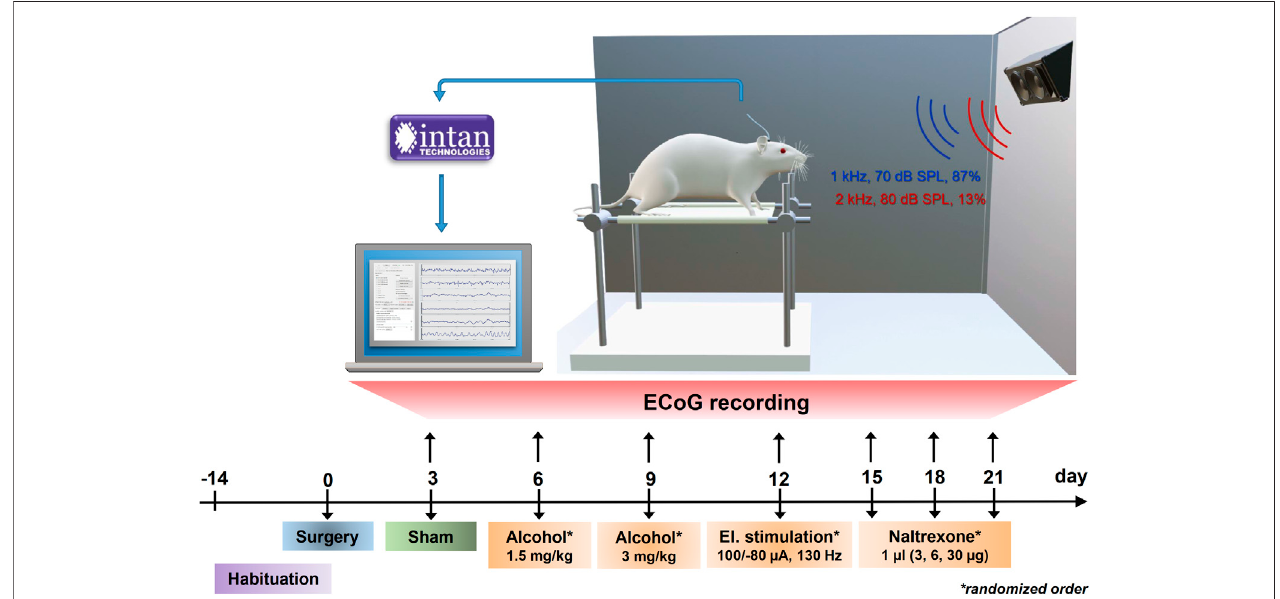
FIGURE 2 | Set-up and timeline for ECoG recording sessions. Experiments were planned as a within-subjects-design with all animals undergoing an initial habituation period, surgicalintervention and neural recordings without previous treatment (sham) and following alcohol injections, electrical brainstimulation and cortical administrationsofNTXinarandomizedorder.Electricalpotentialselicitedduringtheauditoryoddballtaskwereampli fi edanddigitizedatasamplingrateof3 kHzviathe Intan RHD2000 recording system and visualized and saved on a computer using the Intan recording software.